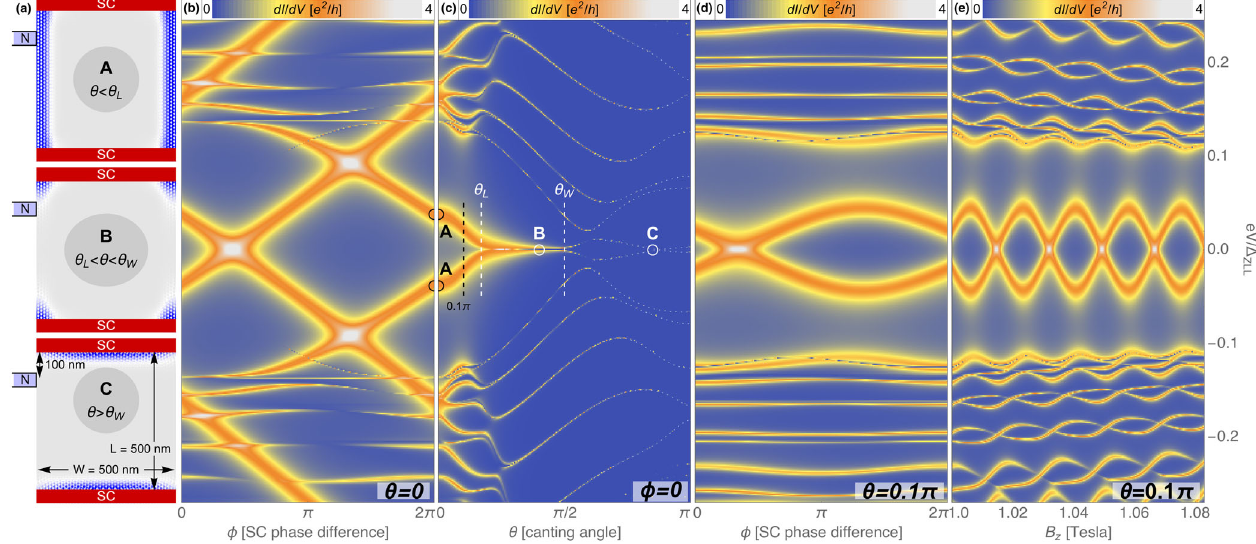
FIG. 3. (a) In blue, density of the lowest Andreev level formed by the hybridization of four Majorana bound states in a square 500 -nm × 500 -nm Josephson junction at different values of canting angle θ . The rest of the parameters are as in Fig. 1. In A and C ( θ < θ and θ > θ , respectively), the hybridization is strong, while in B, it is exponentially suppressed, and the level remains a L W fourfold degenerate zero mode. (b – e) Transport spectroscopy dI=dV from a normal point contact N (transparent, single spinful channel) [see (a)]. (b, d) The dI=dV (at θ ¼ 0 and θ ¼ 0 . 1 π , respectively) as a function of the junction phase difference ϕ . Both exhibit an odd number (one) of zero-energy crossings of edge-resolved dI=dV resonances, signaling a topologically nontrivial system. (c) dI=dV as a < θ < θ function of canting angle θ at ϕ ¼ 0 . It exhibits a zero-bias anomaly in the window θ (see dashed lines). (e) The dI=dV L W dependence with out-of-plane magnetic field B through the sample ( ϕ ¼ 0 , θ ¼ 0 . 1 π ), showing the same zero crossings as with ϕ each z LW is increased by a flux quantum Φ 0 time the total flux Φ ¼ B z